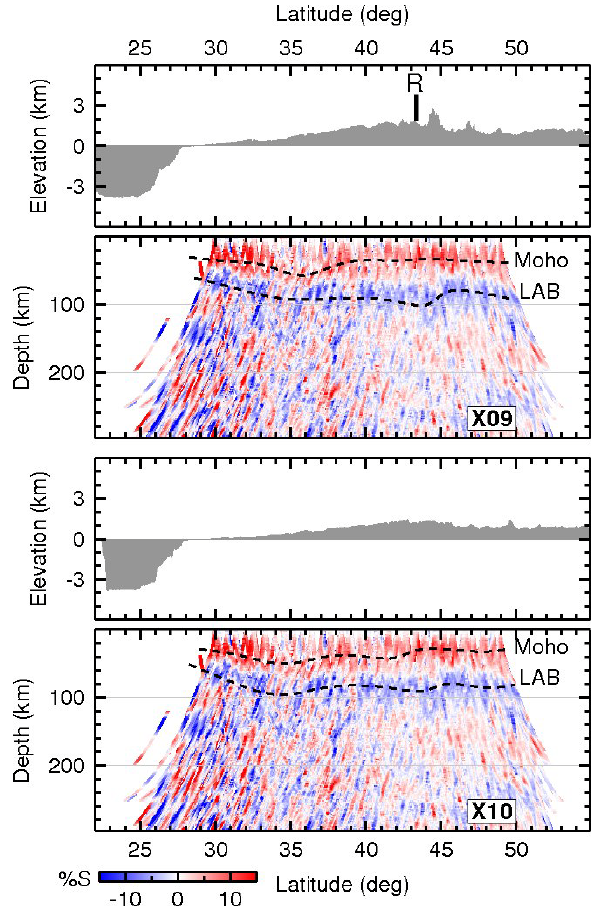
Fig. 16. Migrated S receiver functions along profiles X07 and X08 as in Fig. 3. Fig. 17. Migrated S receiver functions along profiles X09 and X10 as in Fig. Migrated S receiver functions along profiles X09 and X10 as in Fig. 3.